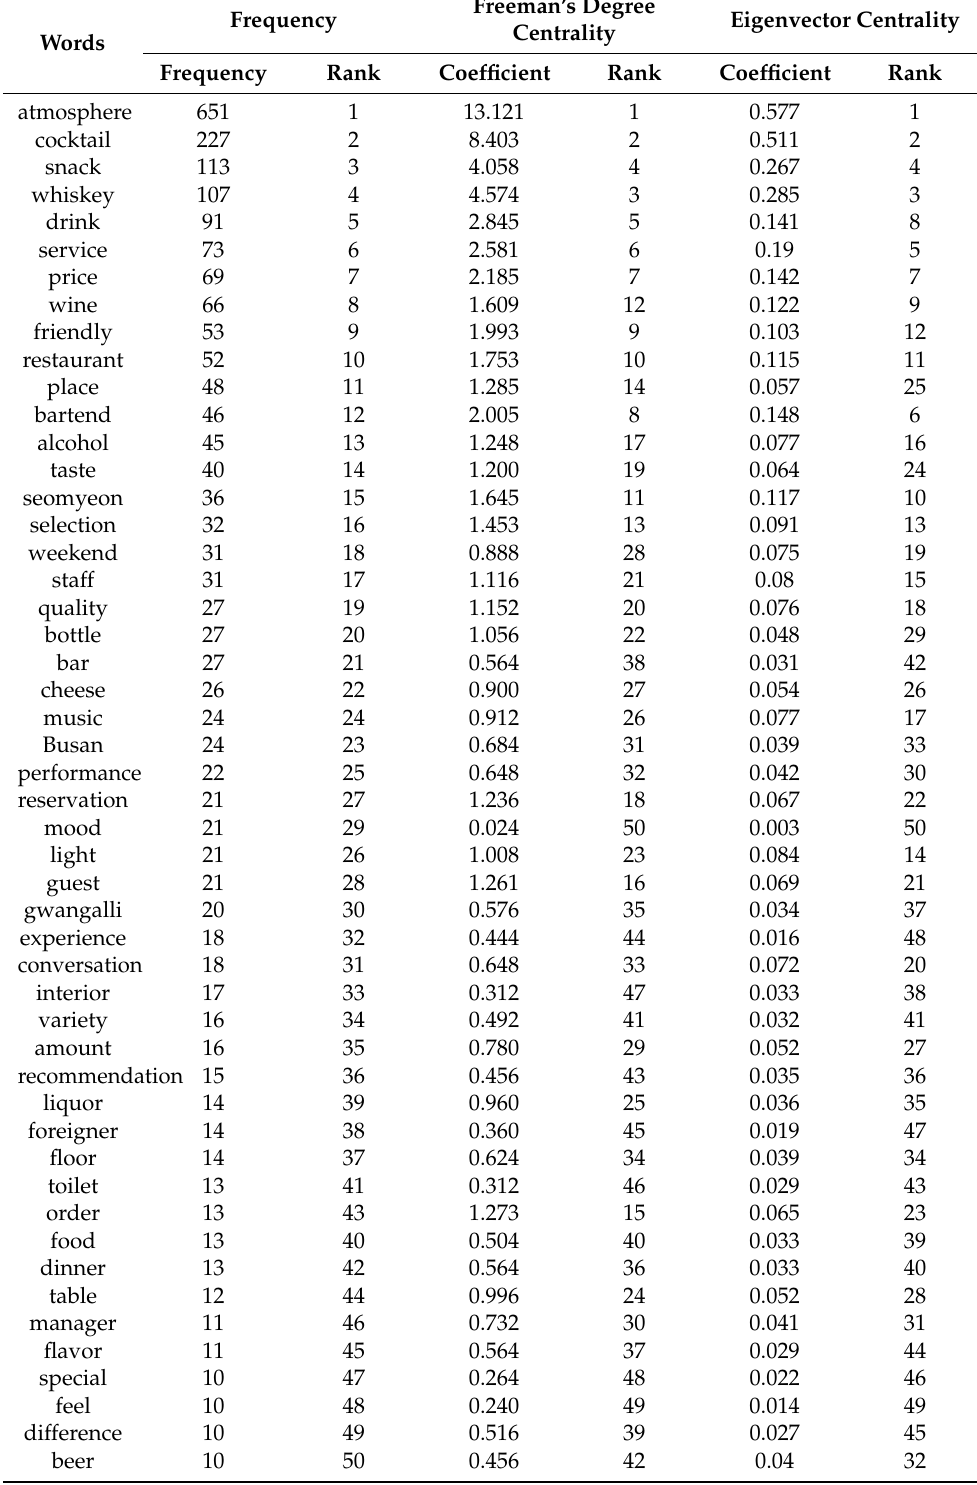
Table 3. Comparison of key words’ frequency and